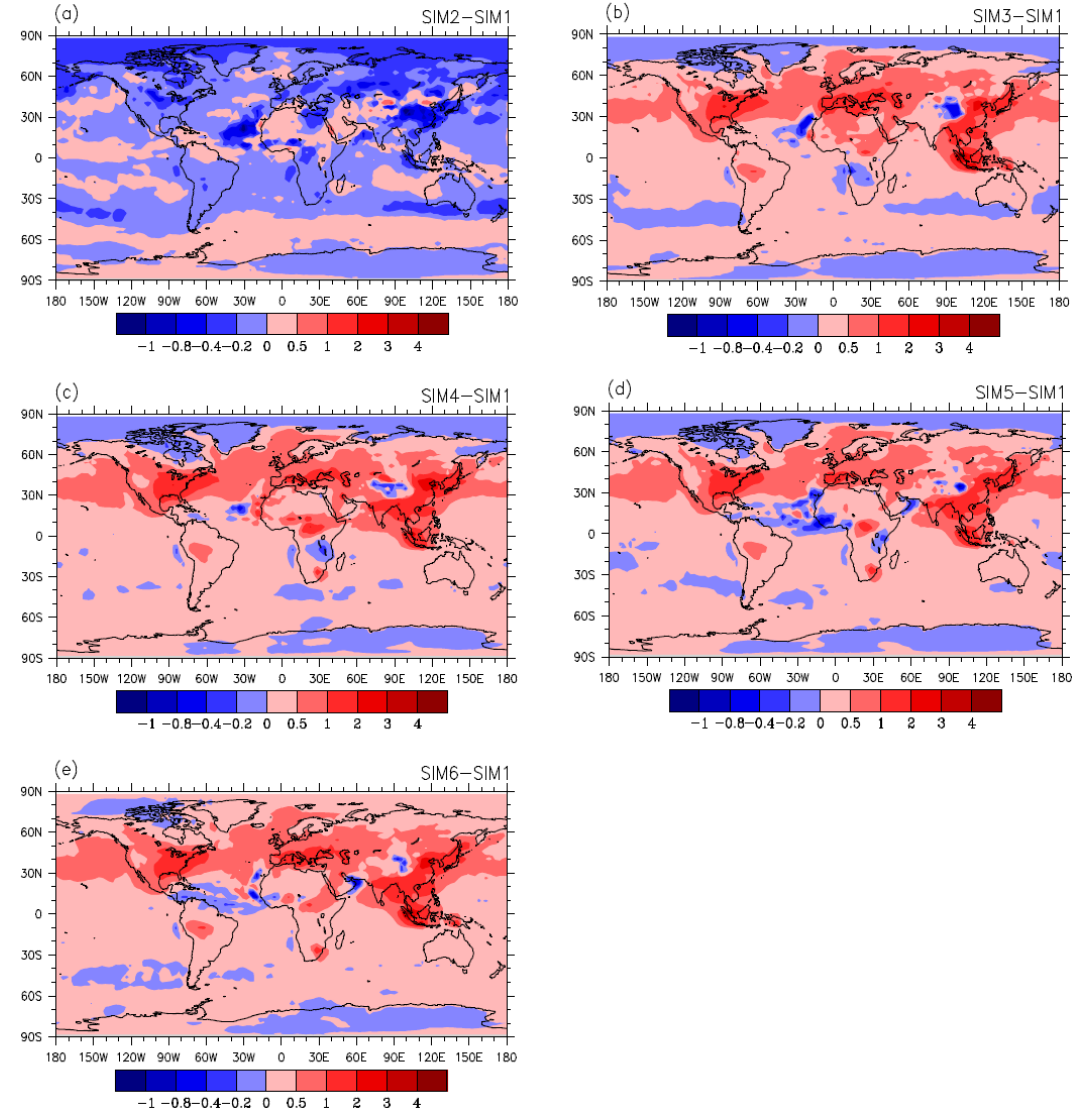
Figure 3. Global distributions of difference in simulated annual mean aerosol direct effect (units: Wm − 2 ). (a) SIM2–SIM1, (b) SIM3–SIM1, (c) SIM4–SIM1, (d) SIM5–SIM1, and (e)